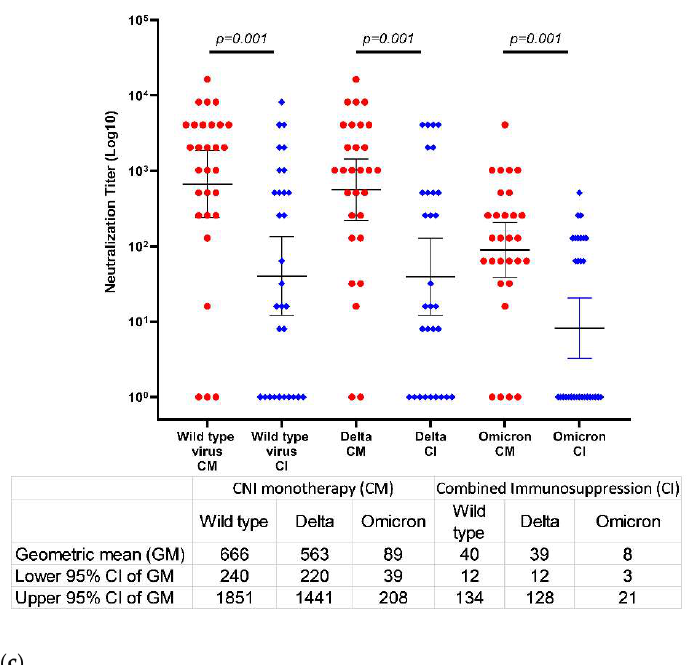
Figure 2. Neutralization of the wild-type SARS-CoV-2 virus and its Delta and Omicron variants of concern 22 days after the third BNT162b2 vaccine dose was administered. Scatter plots showing the neutralization efficacy of liver transplant patients against the wild-type SARS-CoV-2 virus and its Delta and Omicron variants ( a ), the influence of combined immunosuppression (CI) vs. CNI monotherapy (CM) ( b ), and the influence of MMF and mTOR inhibitors vs. CNI monotherapy ( c ). Differences in paired samples were calculated using the Wilcoxon matched-pair signed-rank test.